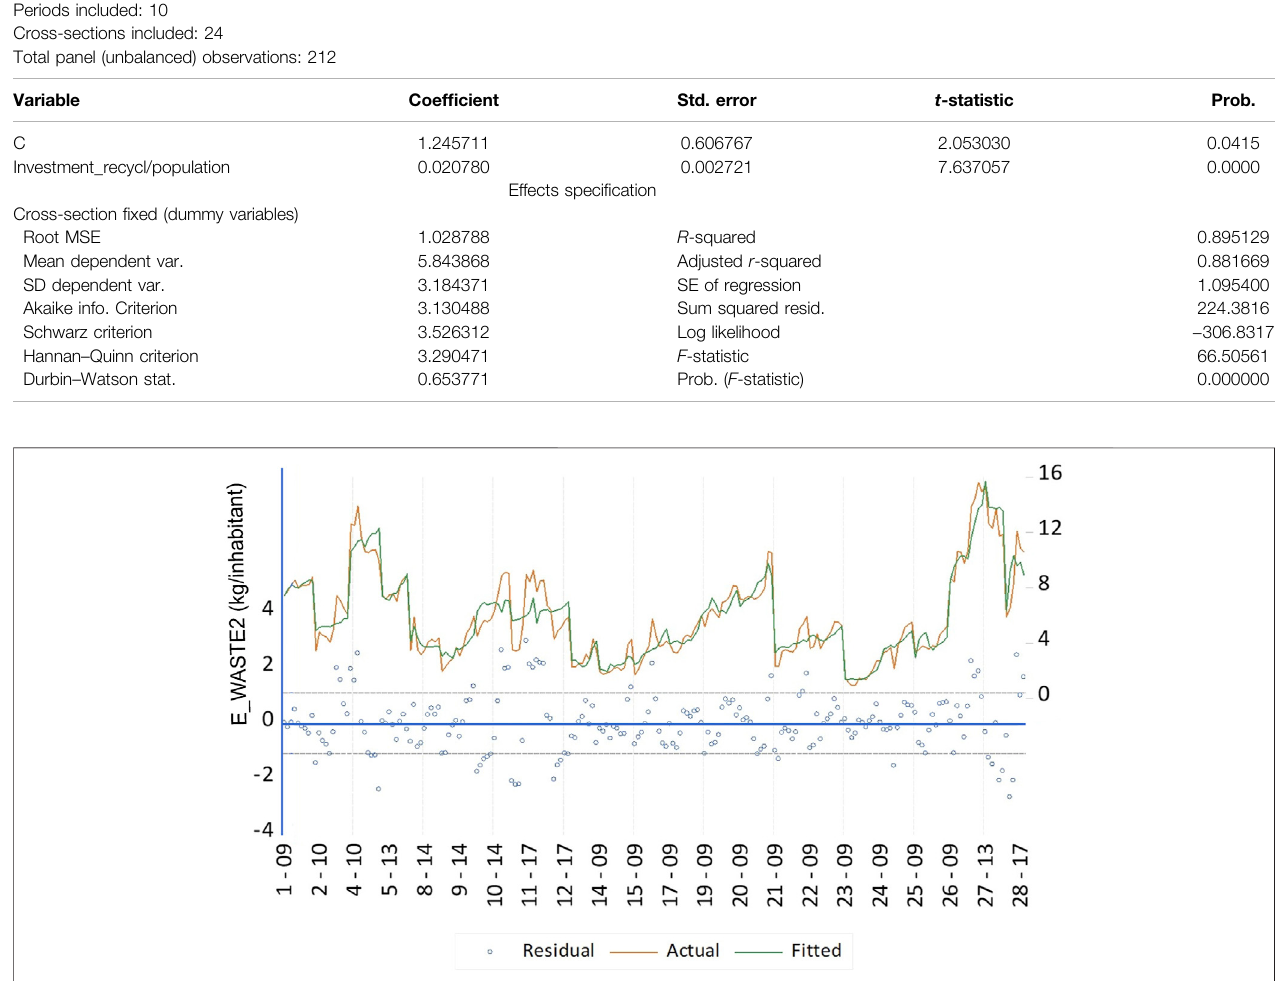
FIGURE 8 | In fl uence of eco-investment on e-waste recycling in the EU (kg/inhab/year, 2008 – 2018)/Source: Own calculation using EViews 11.